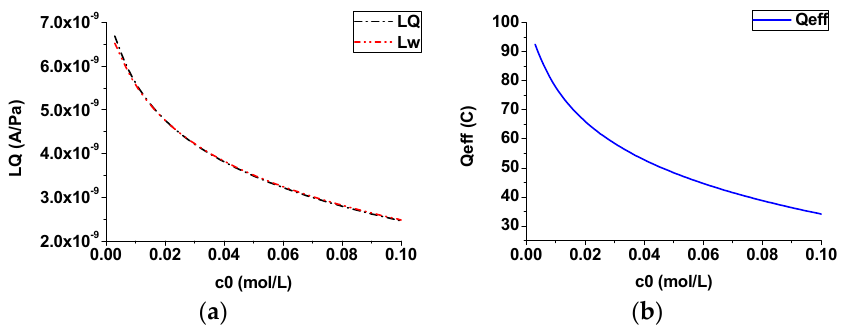
Figure 11. Effect of the salinity (time-harmonic case): ( a ) streaming current coupling coefficient; ( b ) effective net residual charge density.